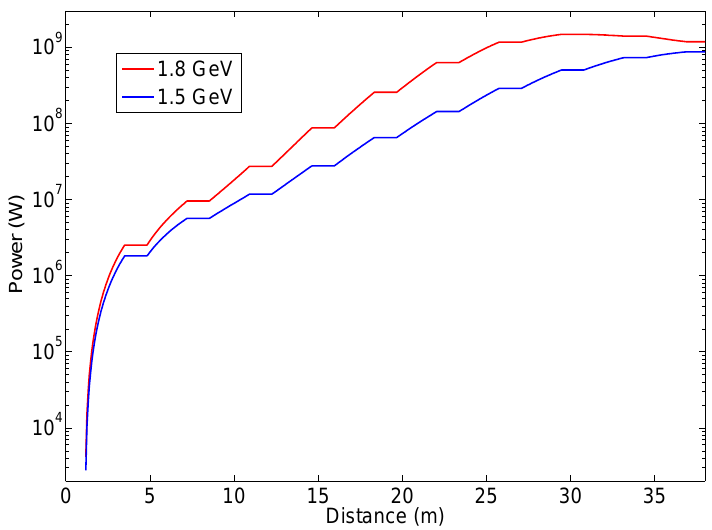
Figure 5. EEHG power at 3 nm as a function of the distance in the radiator. Flat regions (no increase in the power) are due to drift spaces between the radiators to accommodate e-beam focusing optics.